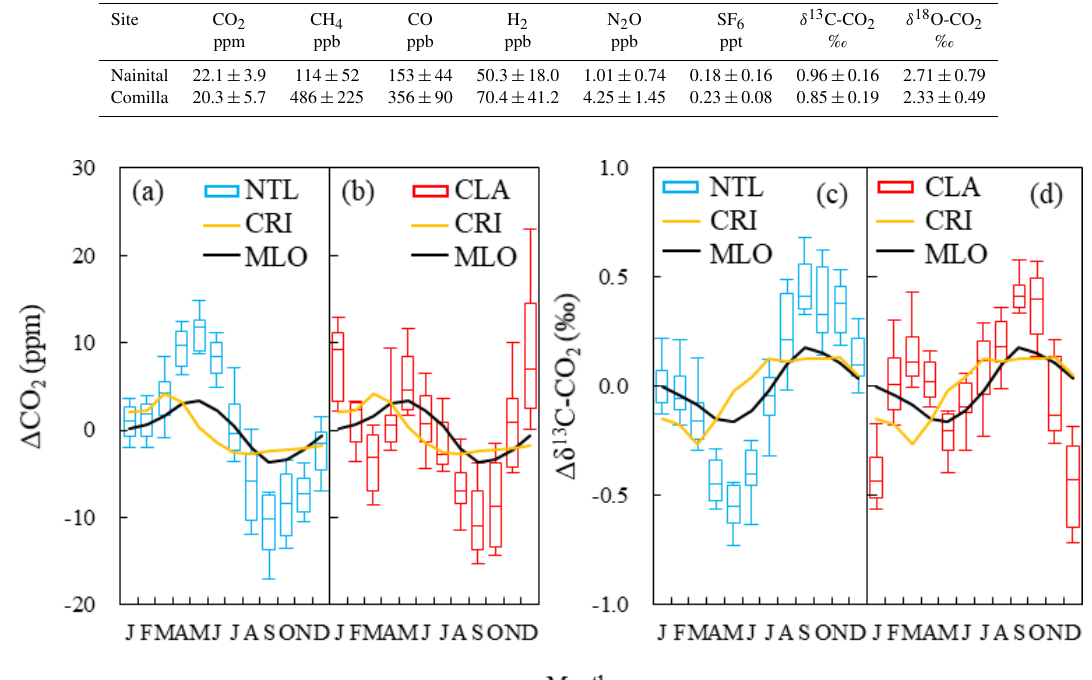
Table 2. Mean annual amplitudes of seasonal variation in atmospheric mole fractions of CO 2 , CH 4 , CO, H 2 , N 2 O, and SF 6 and δ 13 C-CO 2